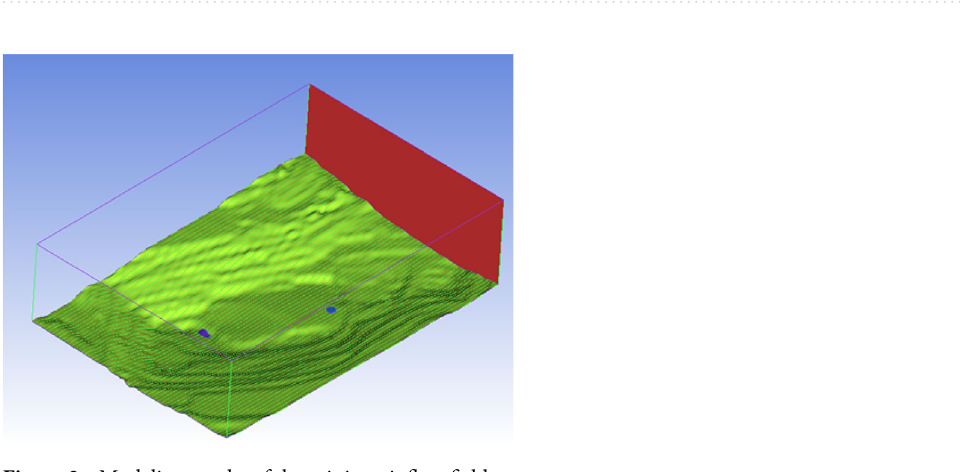
Figure 2. Modeling results of the mining pit flow